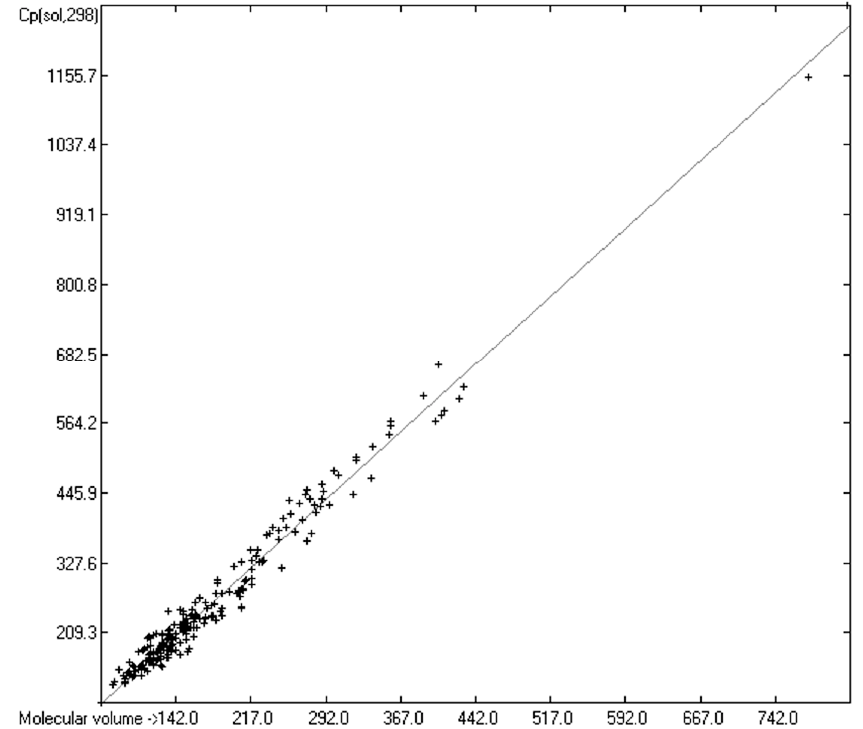
Figure 12. Correlation of molecular volumes with Cp(sol) at 298.15 K of mono- and polyols and -acids. (N = 242, R 2 = 0.9792, σ = 20.87 J/mol/K, MAPD = 6.72%, regression line: intercept = − 14.7861, slope = 1.5364, value range from 91 to 1273 J/mol/K).